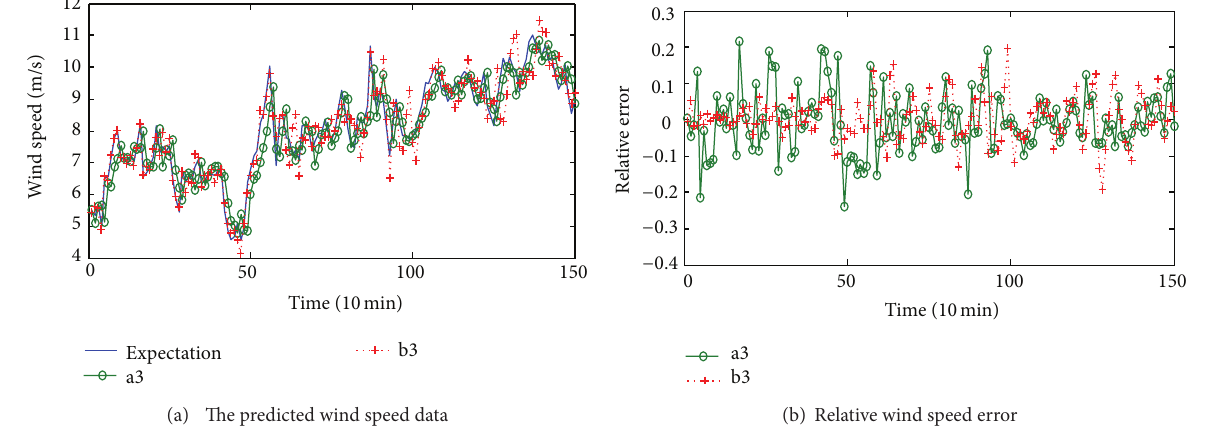
Figure 3: The effect comparison between a3 and